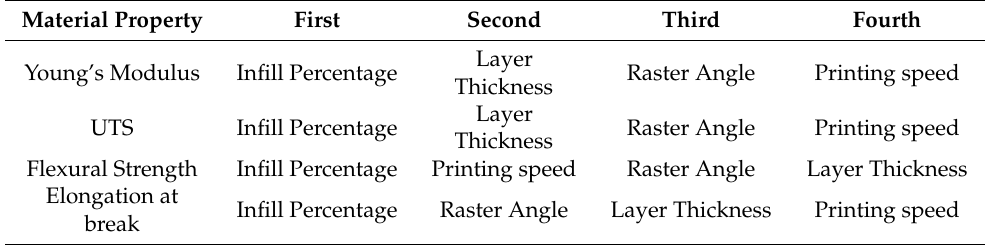
Figure 10. Process parameter’s relative influence on ABS mechanical properties. Table 5. Table ranking parameters according to influence on ABS mechanical properties as determined by ANOVA.